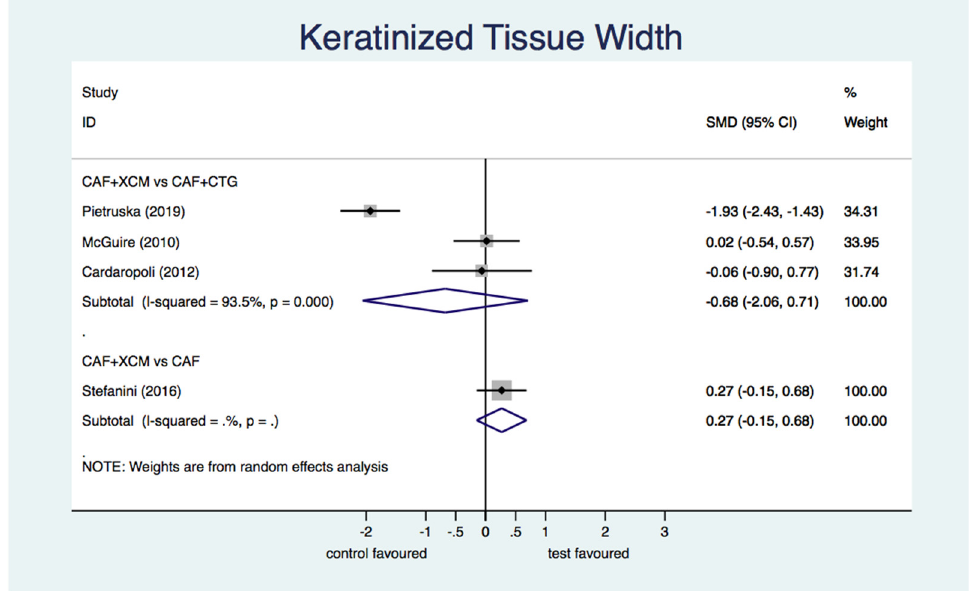
Figure 8. Forest plot relating to keratinized tissue width.